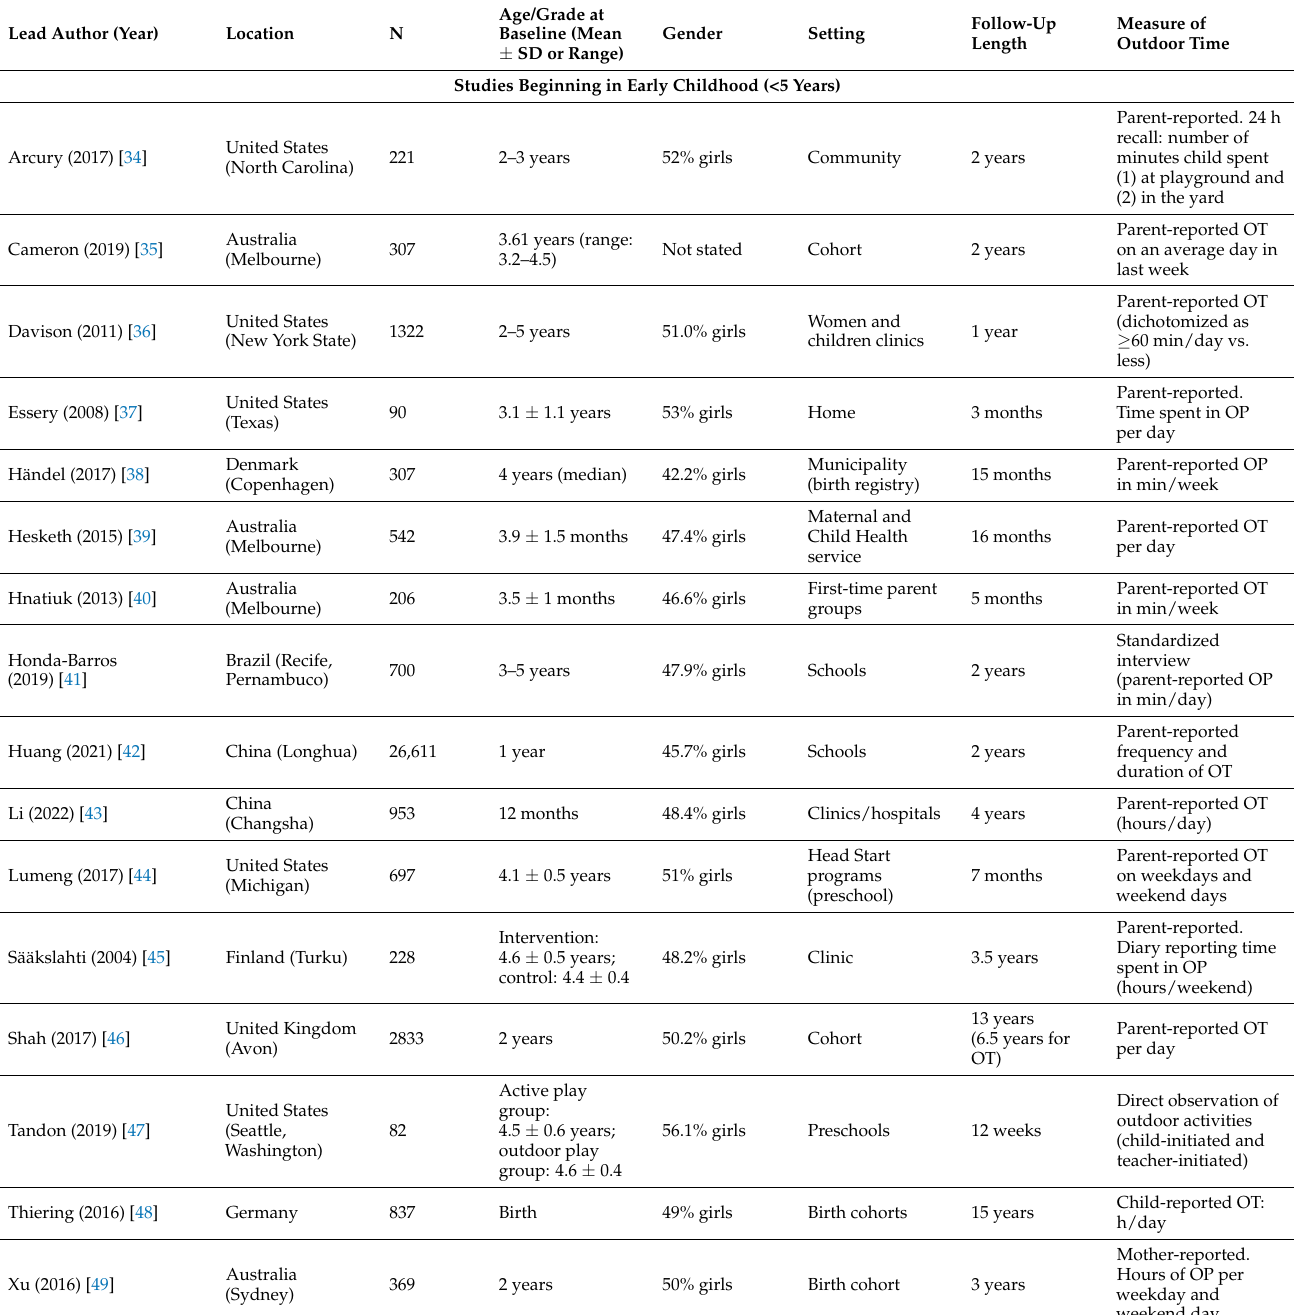
Table 1. Descriptive characteristics of included